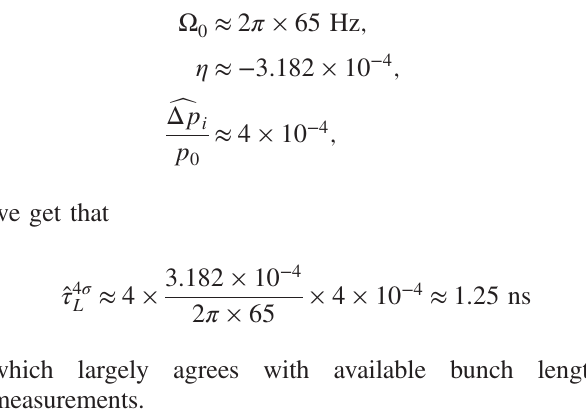
FIG. 2. Representation of a polar phase-space